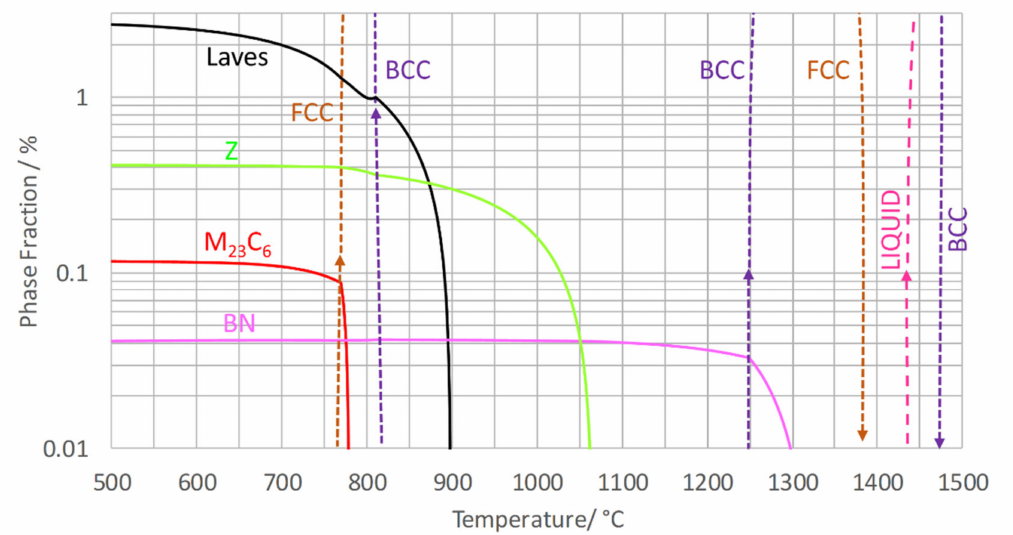
Figure 6. Calculated molar equilibrium phase fractions in ZULC.